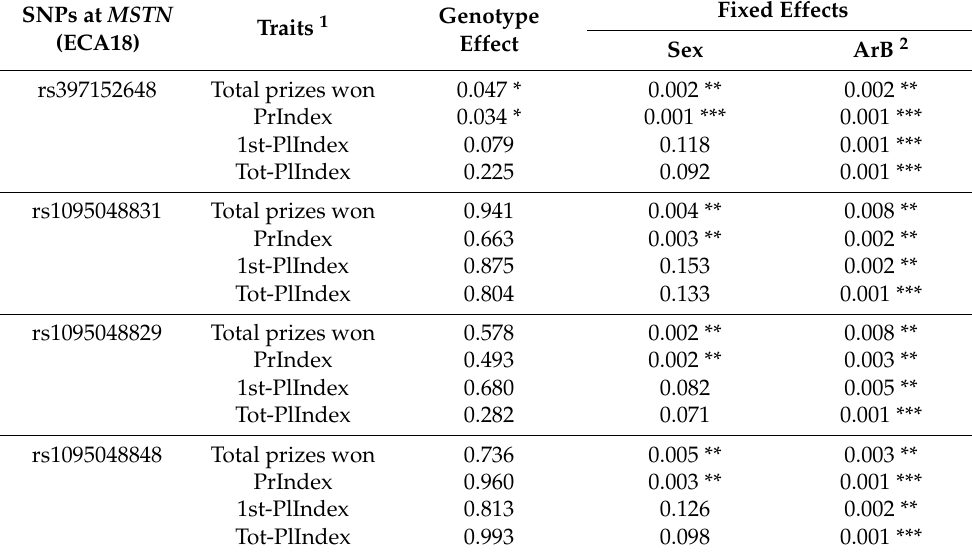
Table 2. Raw p -values and significance for sporting performance traits of the individual horse, according to genotype at equine MSTN (SNP with minimum allele and genotype frequencies higher than 0.05, one SNP at a time) and fixed effects computed in model (M1); samples from 180 Anglo- Arabian horses running 1239 races in their debut year (three year of age). SNPs at